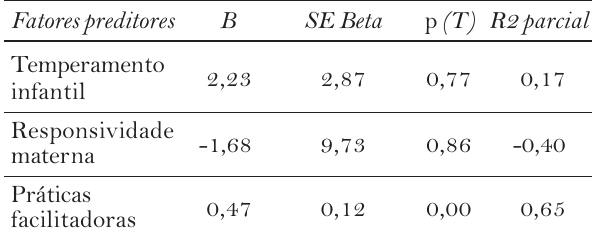
Análise de Regressão Múltipla da Freqüência Total de Indicadores de Competência Social da Criança sobre o Temperamento, a Responsividade e as Práticas Facilitadoras (n=23)